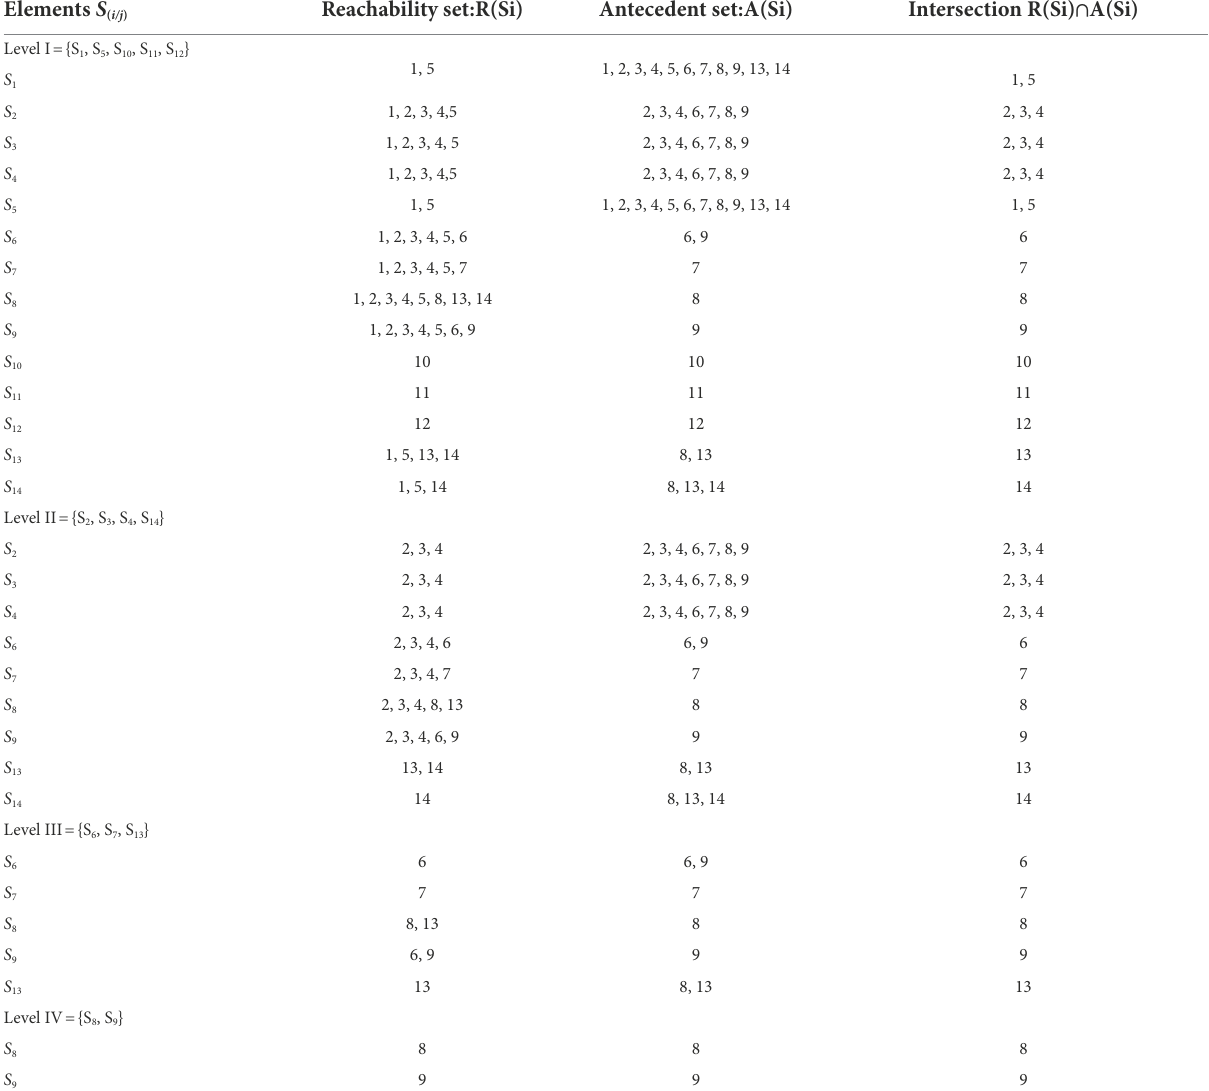
TABLE 5 Level partition of reachability